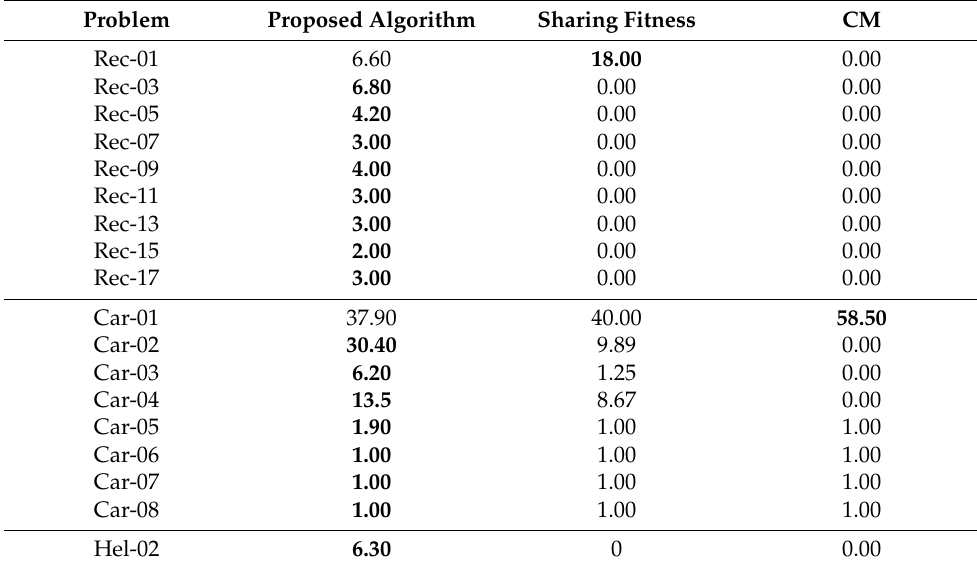
Table 5. Average number of best optimal solutions found ( N O ) using different